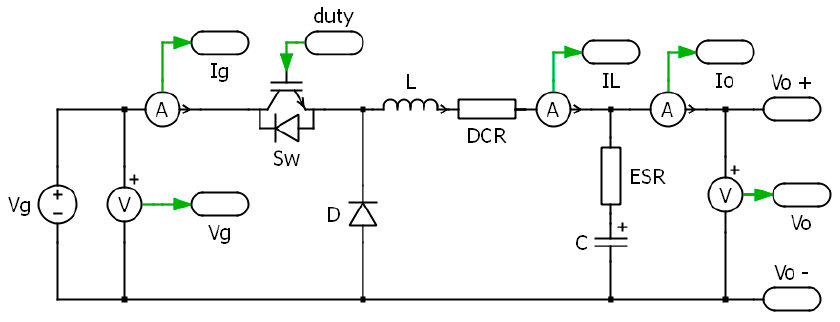
Figure 2. Power Conversion stage of Buck converter modeled in PLECS.